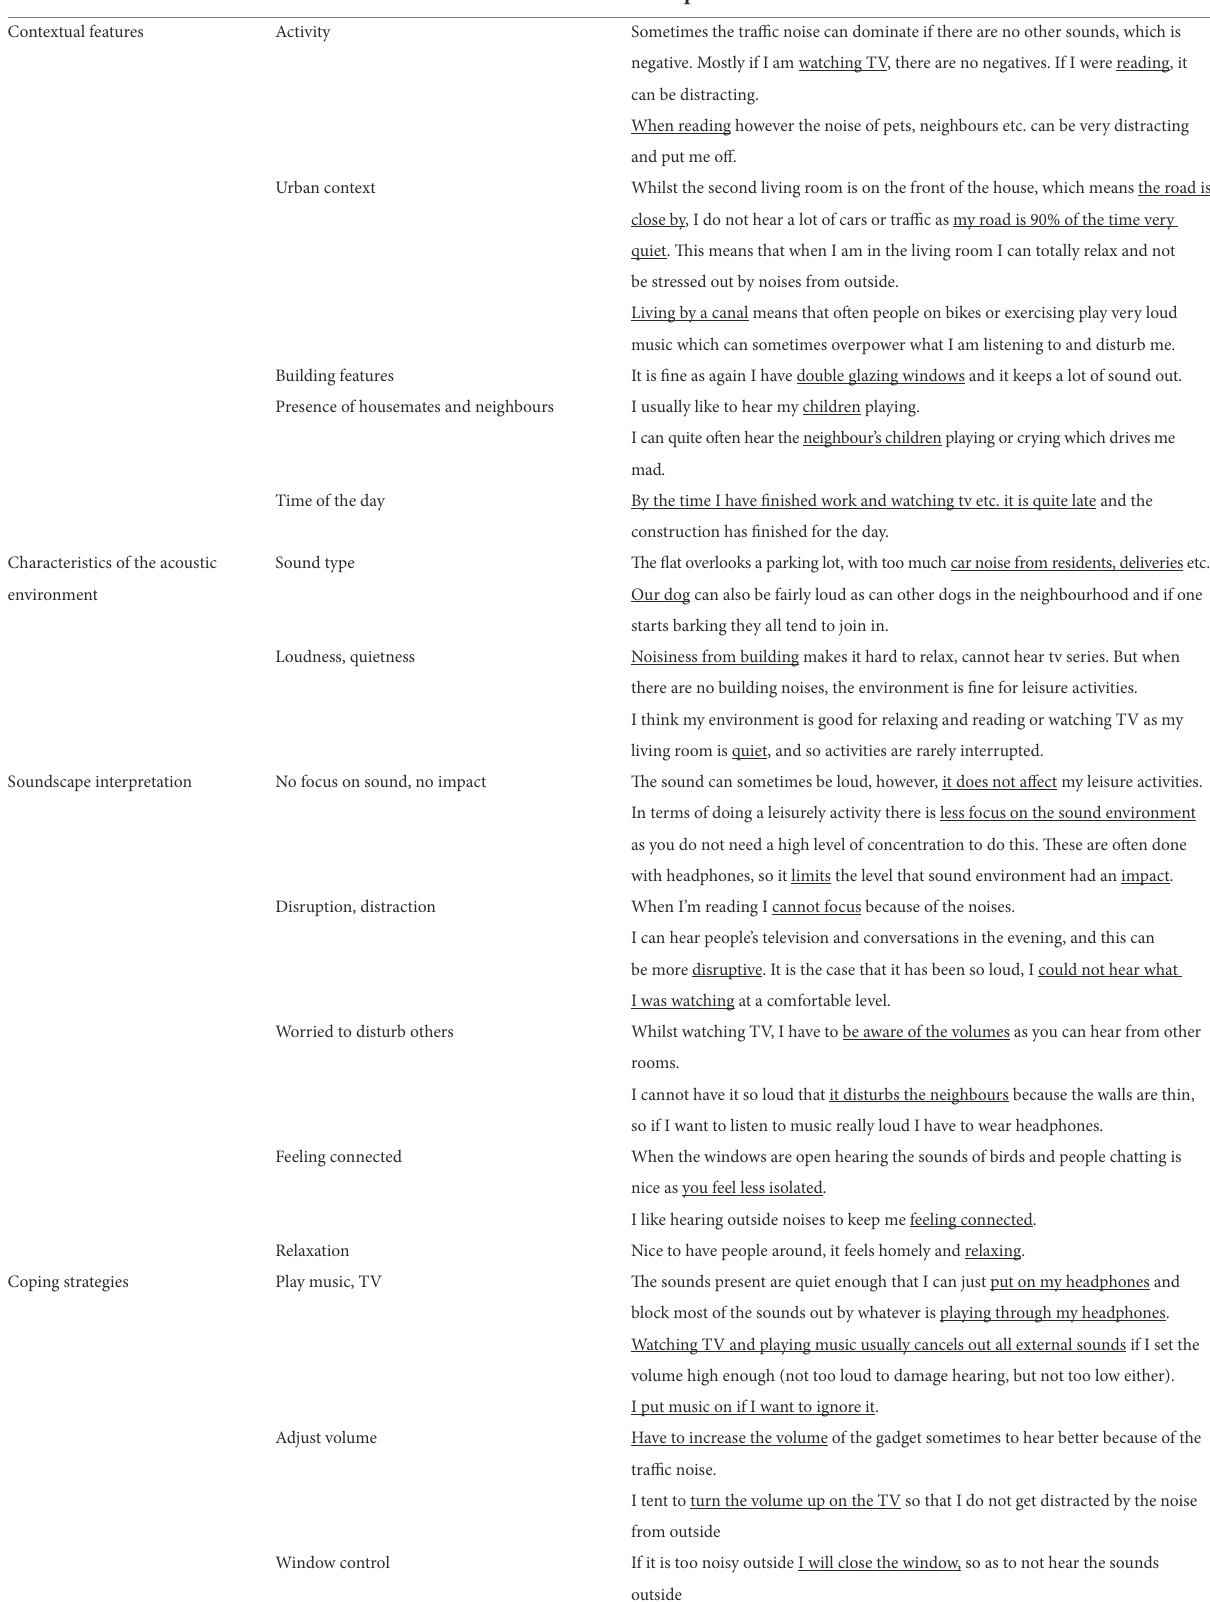
TABLE 3 Example of excerpts and coded fragments (underlined) related to themes and sub-themes defined from the thematic analysis for soundscape impacts on relaxation.